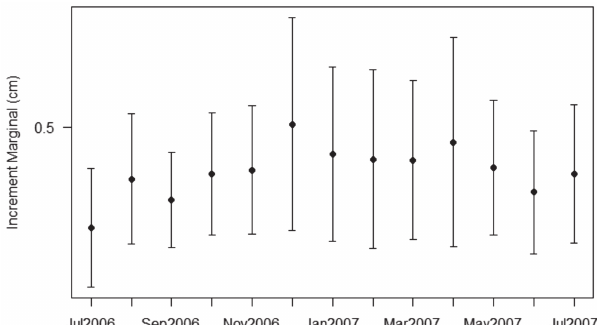
Fig. 3 . Monthly mean values and standard deviation of the marginal increment from otolith of the Piaractus mesopotamicus sampled from July 2006 to July 2007 in the Cuiabá River